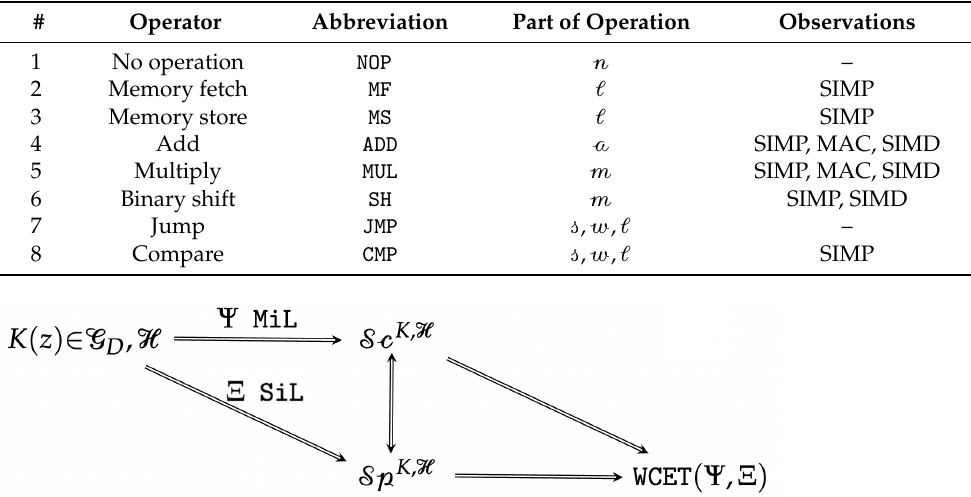
Figure 3. Rapid control prototyping relationship between the formal sets and functionals necessary to perform a worst-case execution time analysis for a regulator K ( z ) ∈ (cid:71) D in the production context (cid:72) .